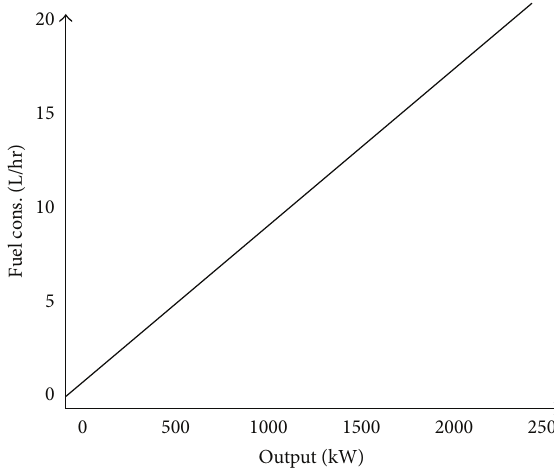
Figure 4: Fuel curve for generator set